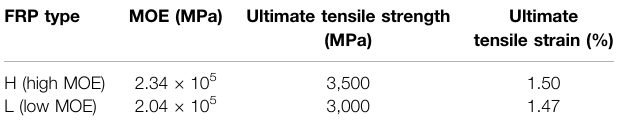
TABLE 2 | Tensile properties of the FRP